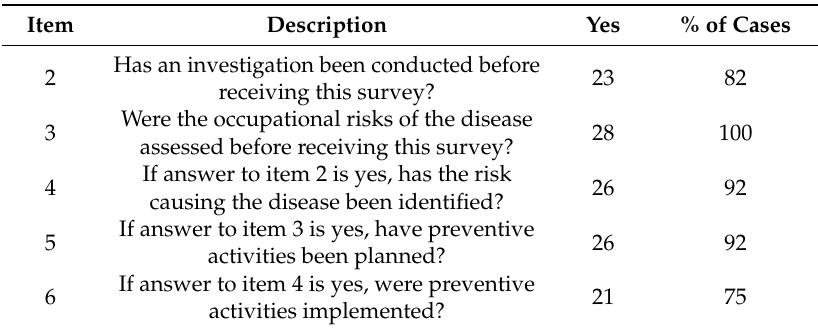
Table 6. Analysis of dichotomic answers when the enterprise knew that the disease notification has been made. Total number of cases: